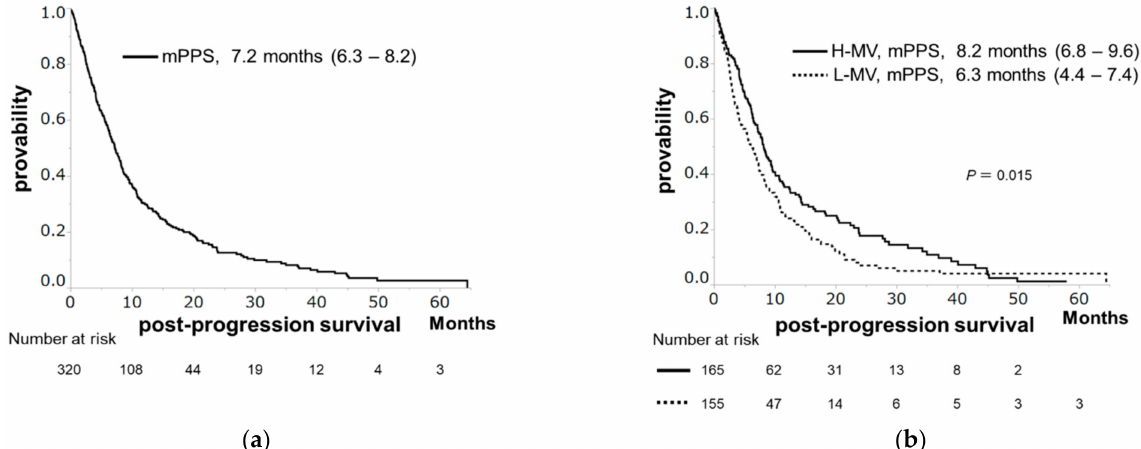
Figure 3. Post-progression survival (PPS) in hepatocellular carcinoma patients receiving sorafenib. ( a ) The PPS rates at 1 and 2 years are 30.3% and 12.6 %, respectively, with a median PPS of 7.2 months. ( b ) PPS according to skeletal muscle volume. Patients with high muscle volume (H-MV) showed significantly longer PPS than those with low muscle volume (L-MV) (median PPS, 8.2 vs. 6.3 months, p = 0.015). Table 2. Univariate and multivariate analyses for predictors of post-progression survival ( n = 320). Factors